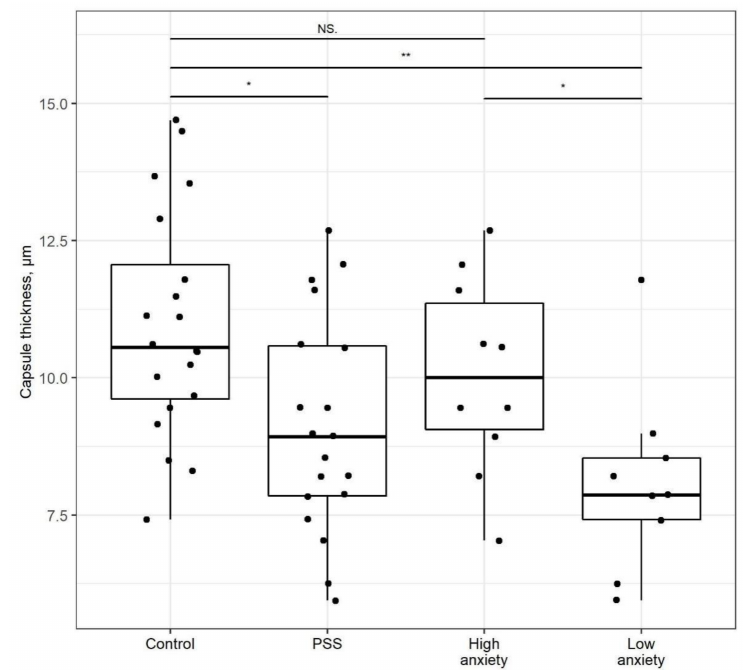
Figure 5. Adrenal capsule thickness is changed after PSS . Capsule thickness of control, PSS, high- and low-anxiety groups. Differences in adrenal cortex thickness values among groups are shown as boxplots with dots rep-resenting individual data values and medians shown by horizontal lines. The boxes include the central 50% of the data, i.e., from the 25th to the 75th percentile. The whiskers include the data contained within 1.5 times the interquartile range. NS = p > 0.05; * p < 0.05; ** p < 0.01. p values determined in parametric